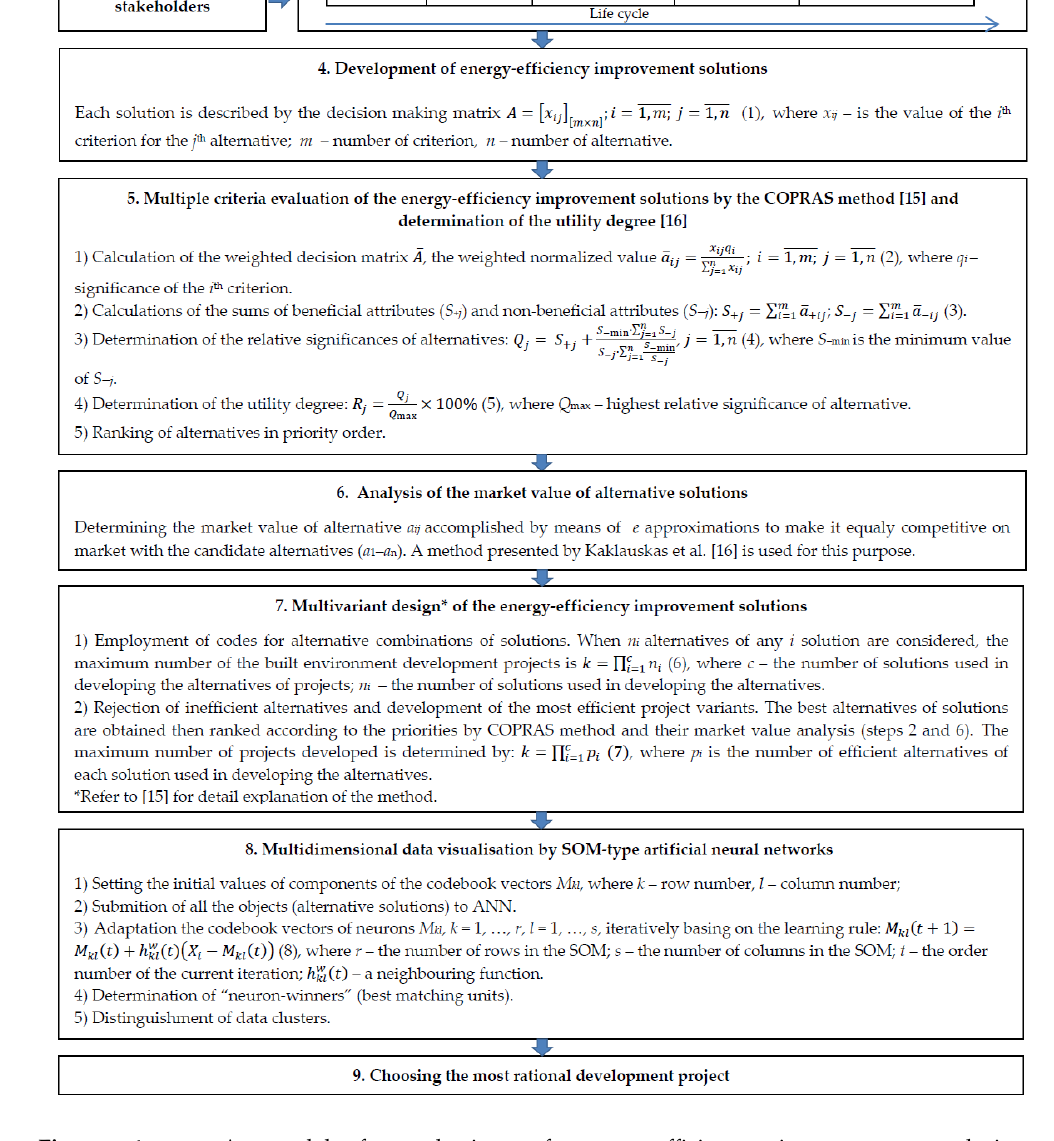
Figure 1. A model for selection of energy-efficiency improvement solutions. SOM — self-organizing map.